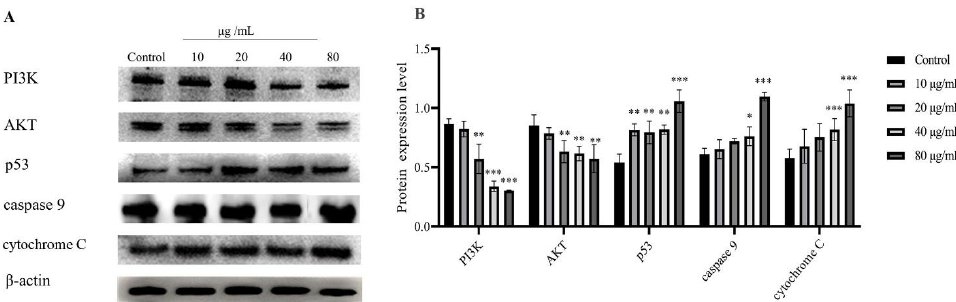
Figure 6. Apoptosis protein markers in MCF-7 cells treated with HSF of KR. ( A ) Immunoblots showing PI3K, AKT, p53, caspase 9, and cytochrome C expression are shown. ( B ) The densitometry of the bands, expressed in arbitrary densitometric units. The expression levels of PI3K, AKT, p53, caspase 9, and cytochrome C were determined by Western blotting analysis. β -actin was used as a loading control. * p < 0.05, ** p < 0.01, *** p < 0.001 vs. control group.